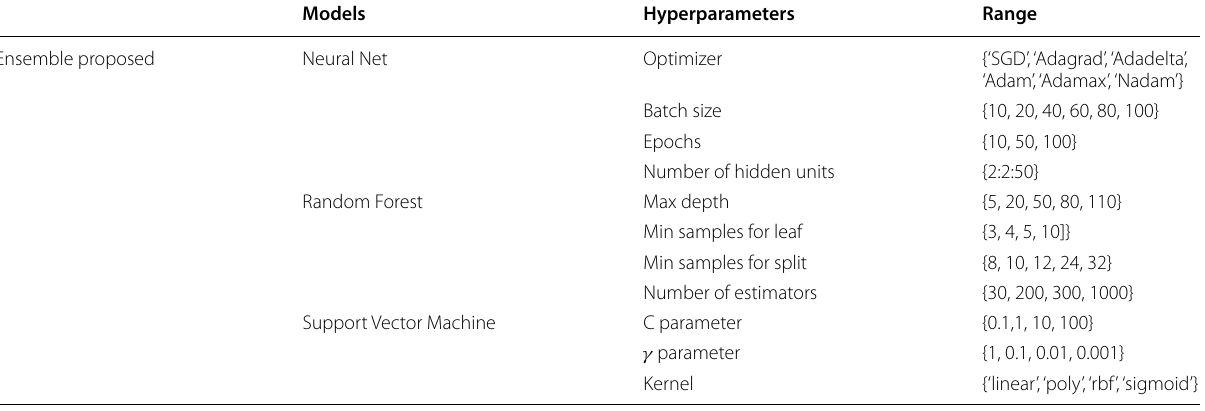
Table 4 Hyperparameters of the three models forming the MEE, and their range used by the grid search